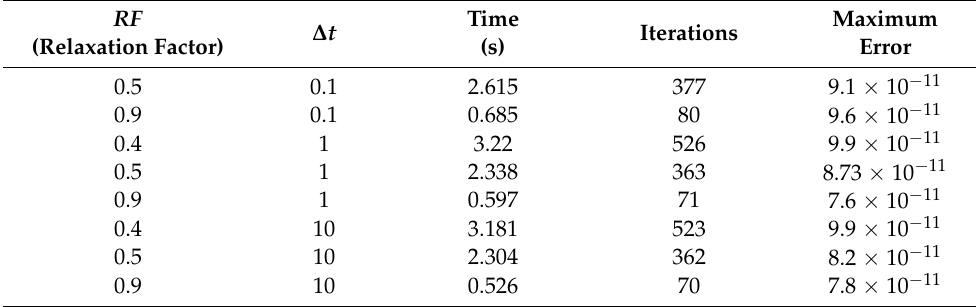
Table 2. RF and ∆ t variation and errors obtained with a 101 × 101 mesh.